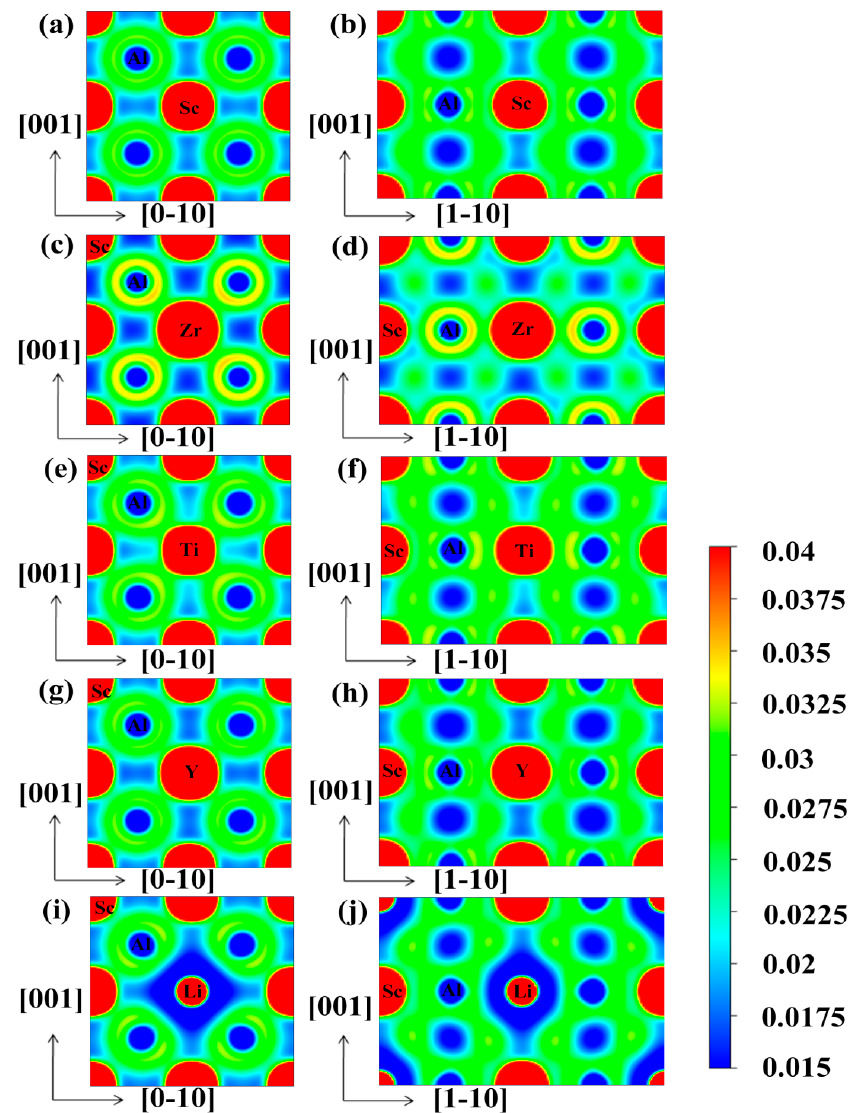
Figure 8. The electron density contour plots (Unit: e/Å 3 ) on the (100) and (110) planes for L1 2 -Al 3